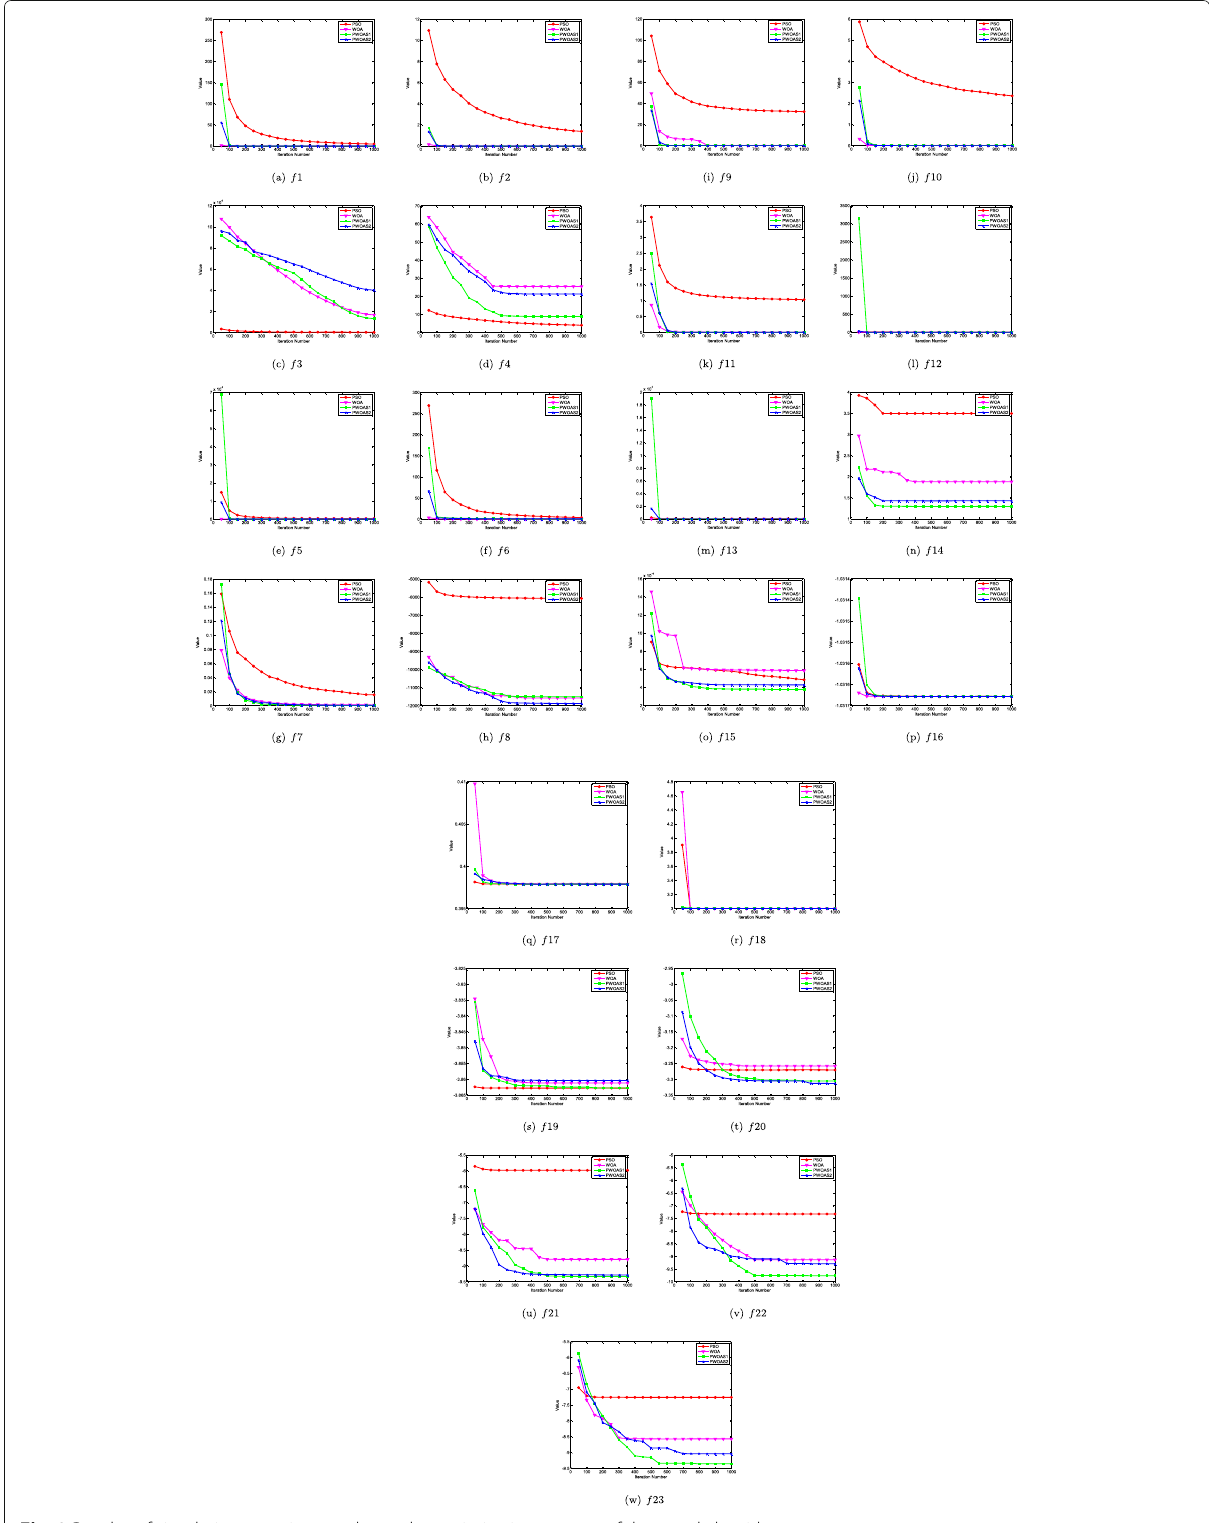
Fig. 3 Resules of simulation experiments shows the optimization process of the novel